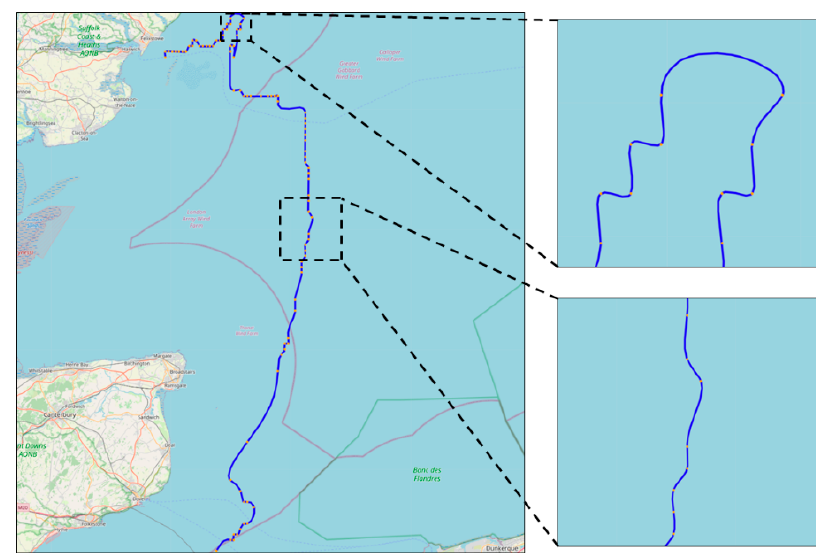
Figure 17. Trajectory reconstruction results with MMSI of 244554000.